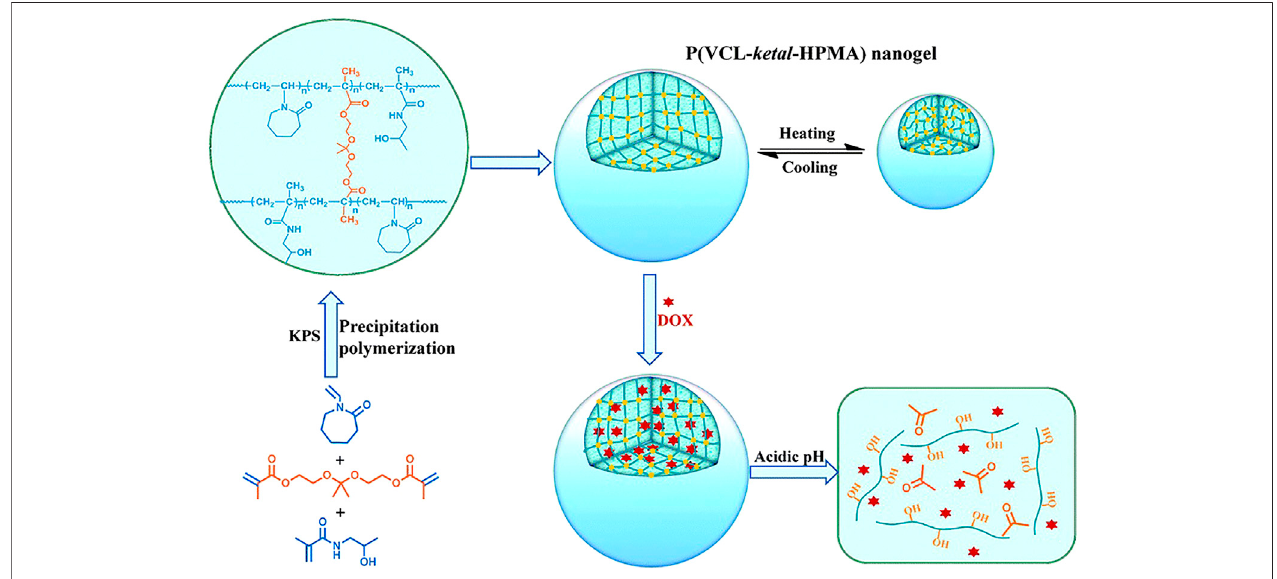
FIGURE 8 | Illustration of the preparation, stimuli-responsive behavior and acid-triggered drug release of the P(VCL- ketal -HPMA) nanogel (Wang et al., 2015). Copyright (2015) Royal Society of Chemistry.